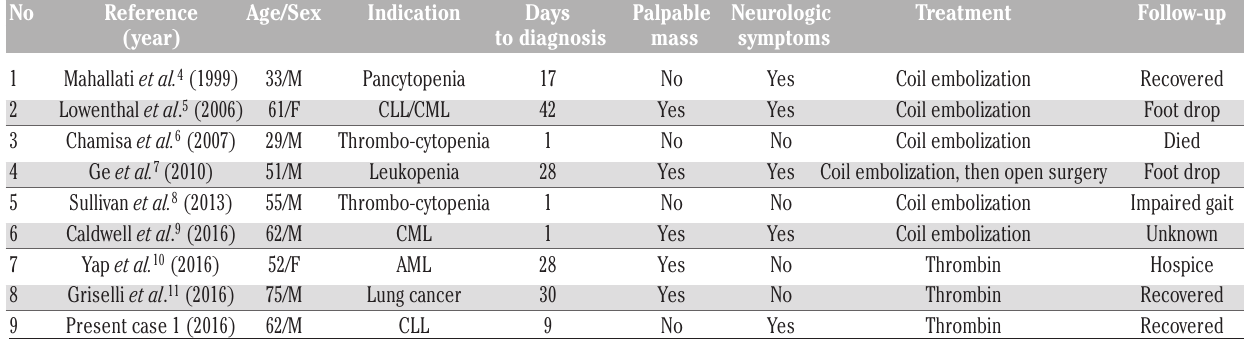
Table 1. Reported gluteal artery pseudoaneurysm after bone marrow procedure.